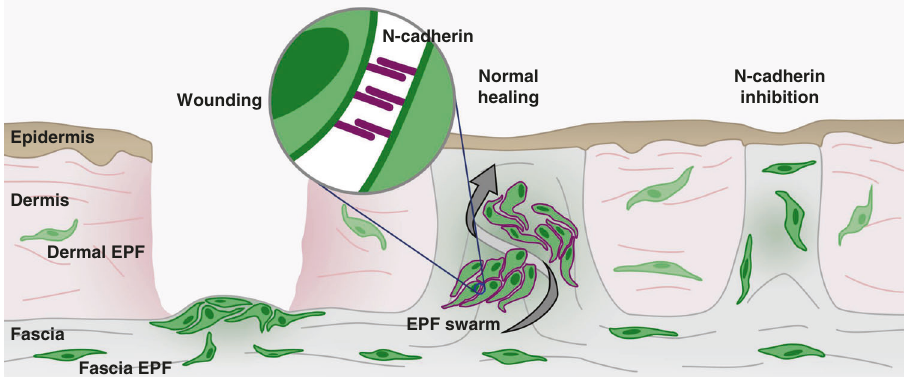
Fig. 7 Scheme of N-cadherin mediated fascia EPF swarms upon wounding and scarring. upon deep wounding, fascia EPFs assemble into aggregates and migrate collectively towards wound centre and then swarm towards epidermis by N-cadherin (purple) mediated cell-cell adhesion. Fascia EPF swarming triggers fascia mobilisation into wounds, contracts skin and drives scar formation. EPF swarms are absent in the tissues without fascia (e.g. oral mucosa) or when N-cadherin is inhibited by chemicals (eg. Exherin) or genetic mutations. The absence of collective migration of fascia EPF swarms results in less scar (Fig. 7). Fascia EPFs upregulate N-cadherin upon wounding. The elevated intercellular adhesion is required for the aggregation and towards wound centres. Swarming of fascia EPF triggers fascia mation. In the tissues without fascia (eg. oral mucosa) or when N- cadherin is inhibited chemically (eg. Exherin) or genetically, fascia EPF swarming is absent, resulting in minimal scars.